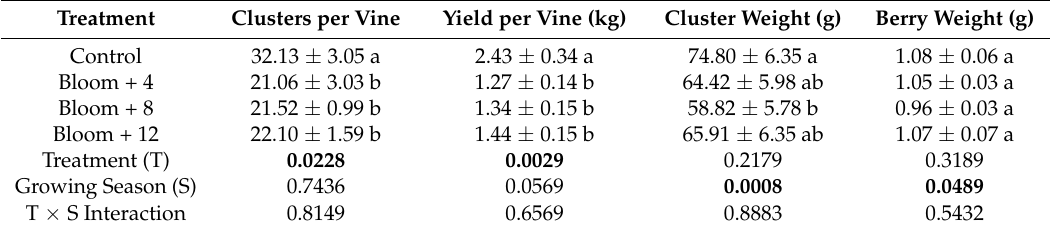
Table 2. Two-way analysis of variance (ANOVA) with interaction showing mean values and p -values of vine yield components by cluster thinning treatment. Combined two-year averages followed by standard error of the mean. Also shown are p -values corresponding to main effects and the interaction between treatments and growing season. Different letters within a column indicate significant differences between treatment groups for Fisher’s least significant difference (LSD) test at p < 0.05. p values below 0.05 are shown in bold fonts.